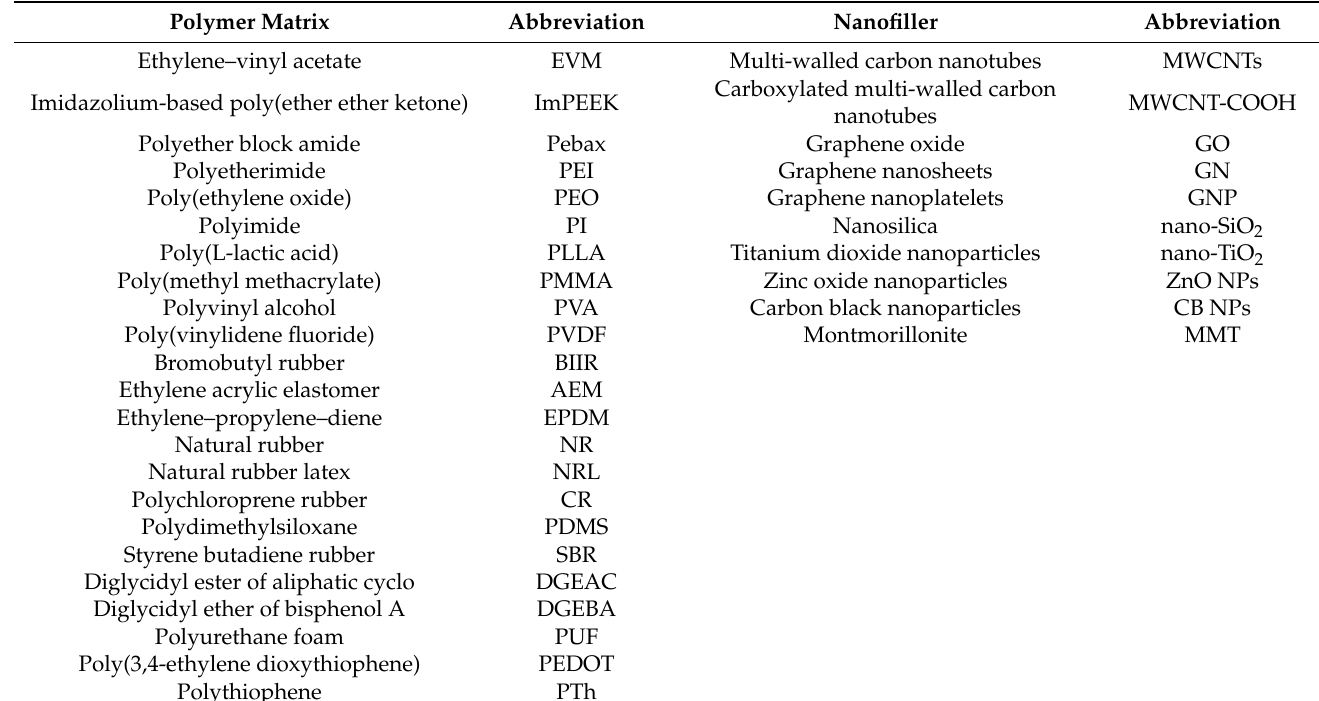
Table 2. Examples of polymer matrices and nanofillers used for fabrication of polymer